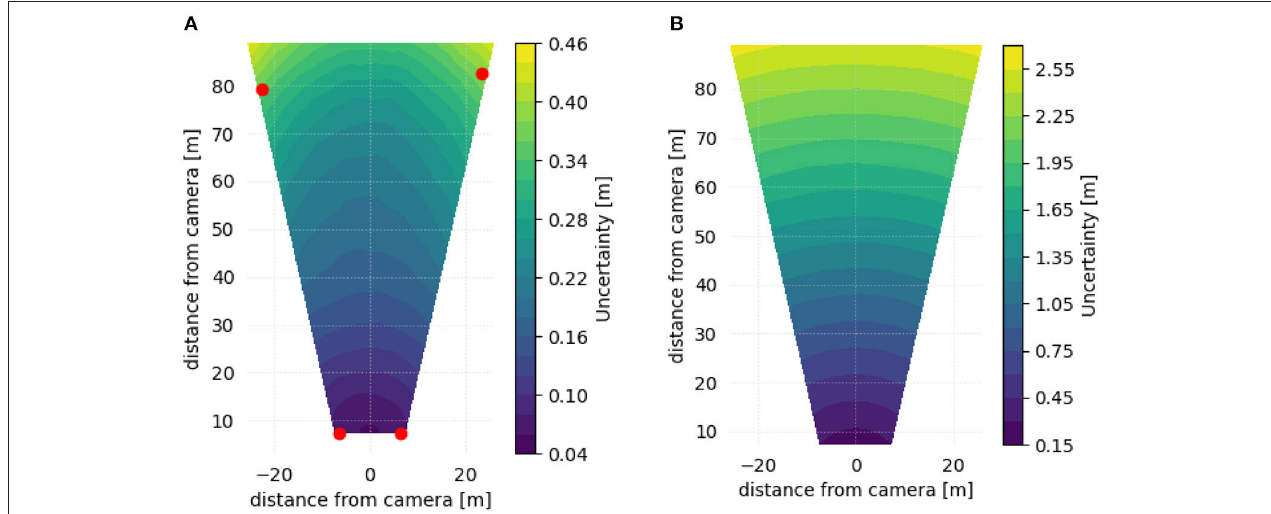
FIGURE 1 | Contours of the 95th percentile of spatial uncertainty estimated at each pixel footprint in an oblique view camera setup, after correcting the images for radial distortion. (A) Using 4 GCPs located near the corners of the FOV (red dots). (B) Using direct